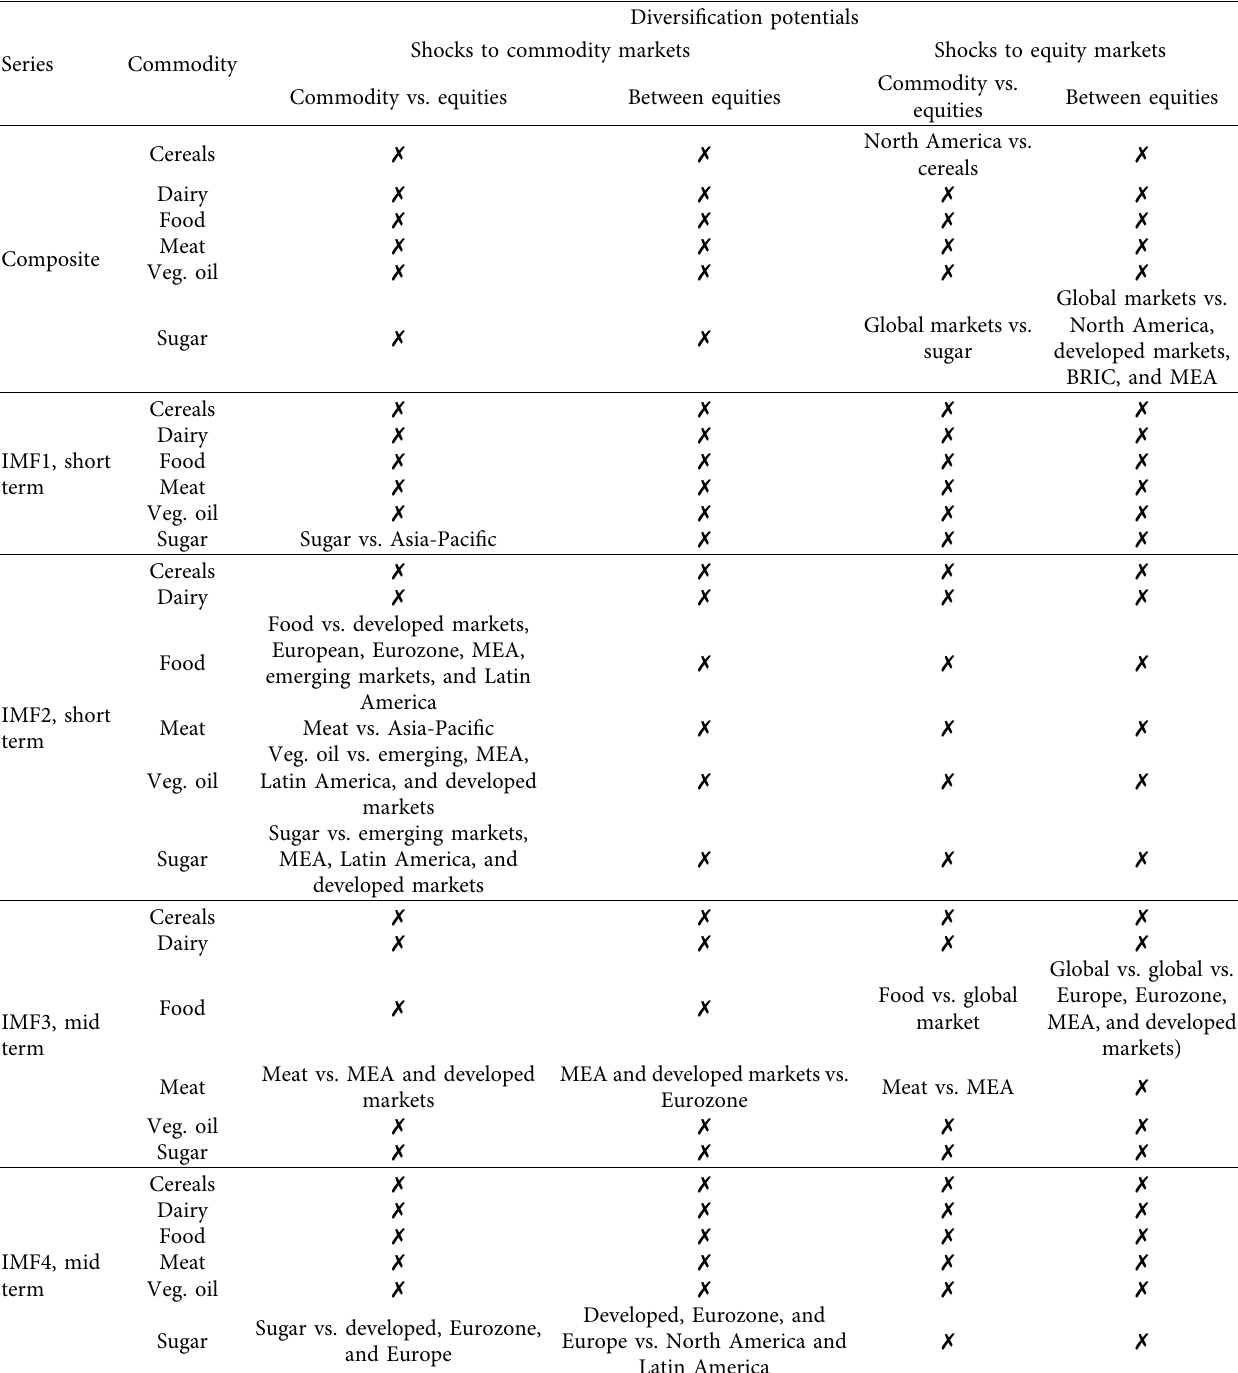
Table 3: Summary of